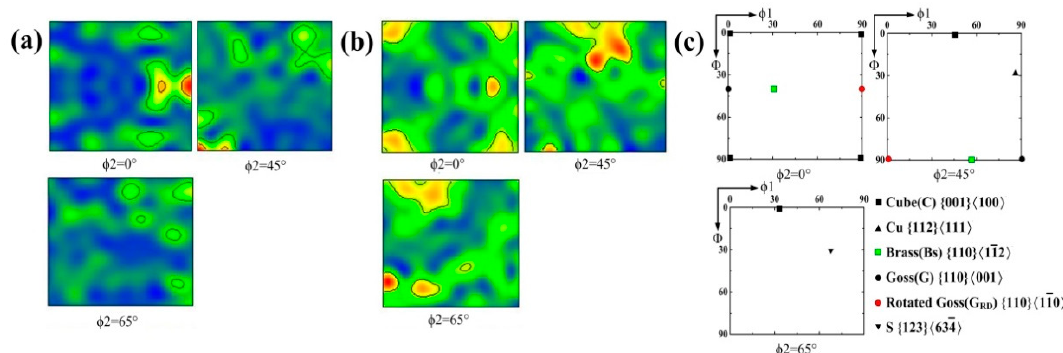
Figure 10. Schmid factor of the different thicknesses of plates along the fusion line: ( a ) 1670-8 and ( b ) 1670-14.